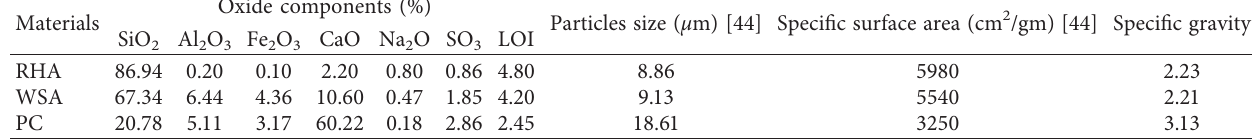
Table 1: Oxide’s percentages and physical properties of PC, WSA, and RHA.